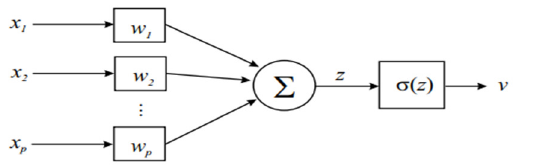
Fig. 7: Single neuron with weights and activation function